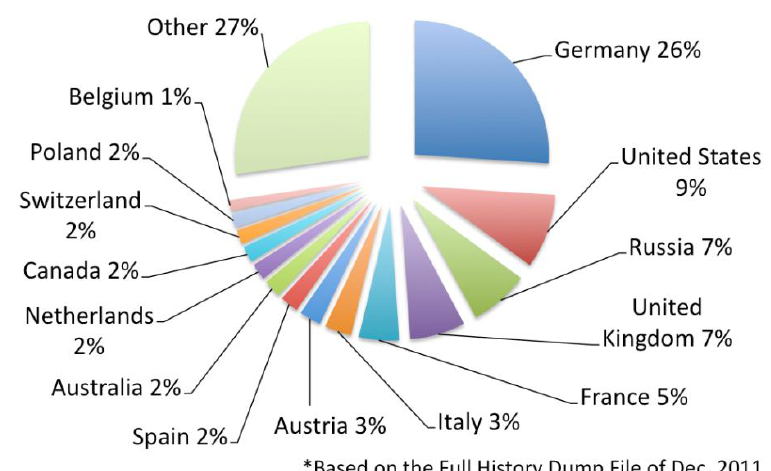
Figure 9. Contributors per